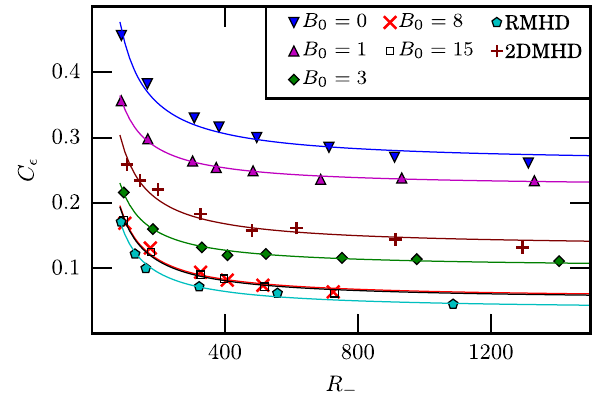
FIG. 1. Dimensionless dissipation rate ð C ϵ Þ plotted as a function of generalized Reynolds number R − for three- dimensional runs with different values of mean field B 0 , one set of two-dimensional runs, and one set of reduced MHD runs along with fitted polynomials represented by continuous lines of the same color as the corresponding runs.